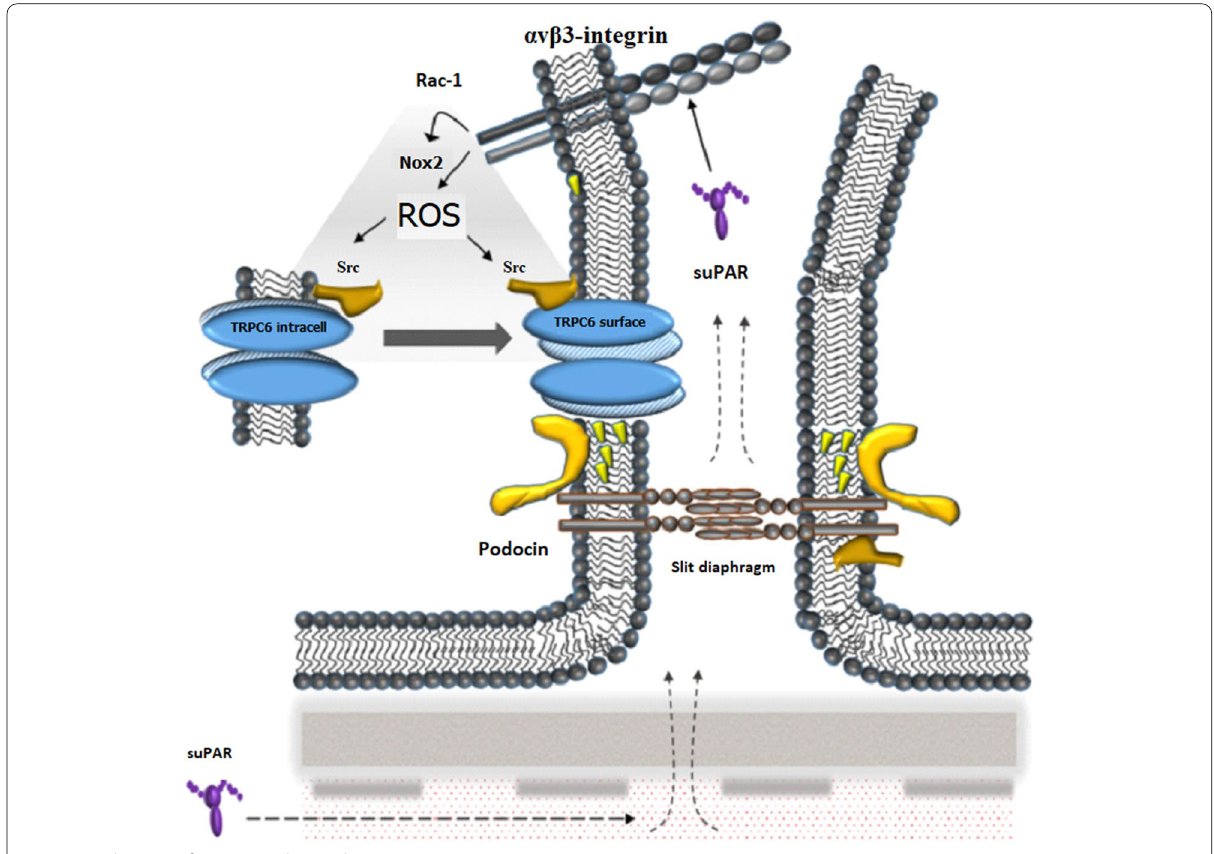
Fig. 2 Mechanism of suPAR on glomeruli